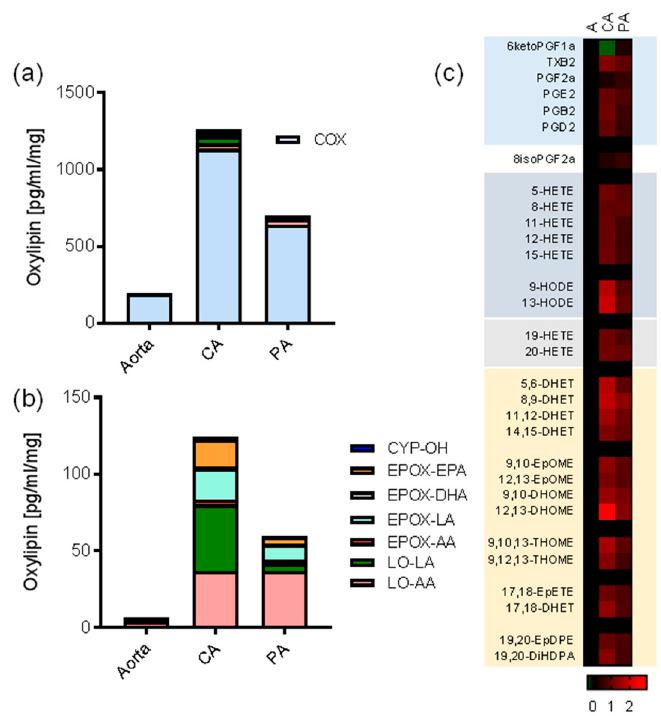
Figure 1 . Characterization of oxylipin production from aorta, coronary artery, and pulmonary artery.